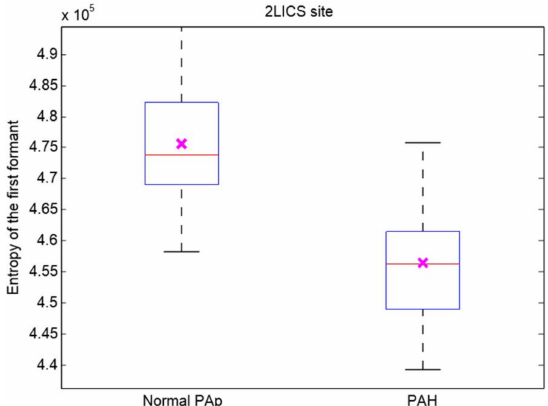
Figure 4. Boxplot of the entropy of the first sinusoid formant extracted from the heart sounds recorded at the 2 nd left intercostal space. The left box represents the entropy of the first sinusoid formant extracted from the heart sounds with a mean pulmonary artery pressure of 5–24 mmHg ( n = 35), while the right box represents the entropy of the first sinusoid formant extracted from the heart sounds of children with a mean pulmonary artery pressure 25 − 93 mmHg ( n = 25). The cross in each box refers to the statistical mean. Two-sample independent t -test was performed and a significant difference was detected between subjects with a normal pulmonary artery pressure and those with pulmonary artery hypertension ( p < 0.05). Red line = median. Abbreviations: Normal PAp = normal pulmonary artery pressure, PAH = pulmonary artery